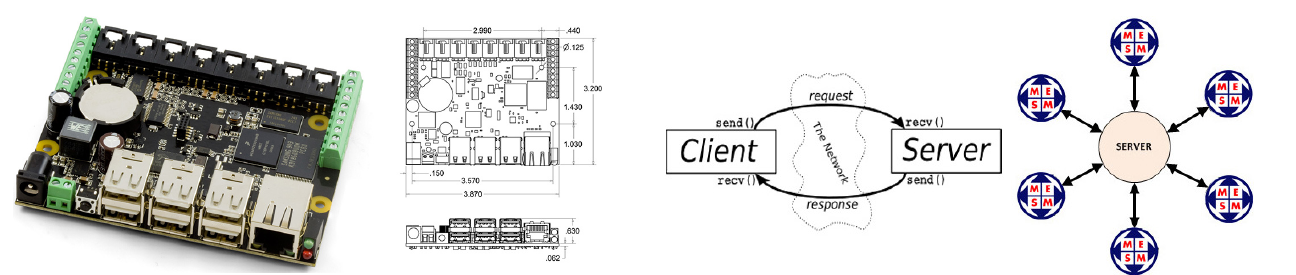
Figure 7. Schematic example of the client-server system that will be implemented under the MEMS